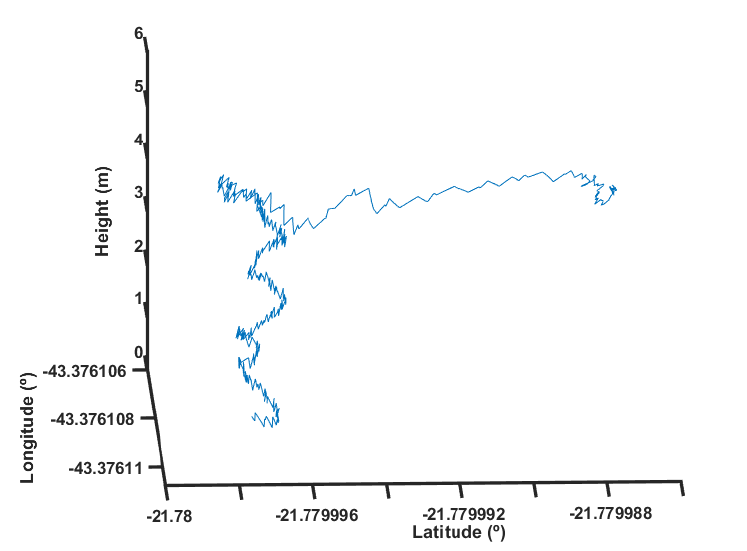
Figure 23. Height response with fuzzy scheduling.